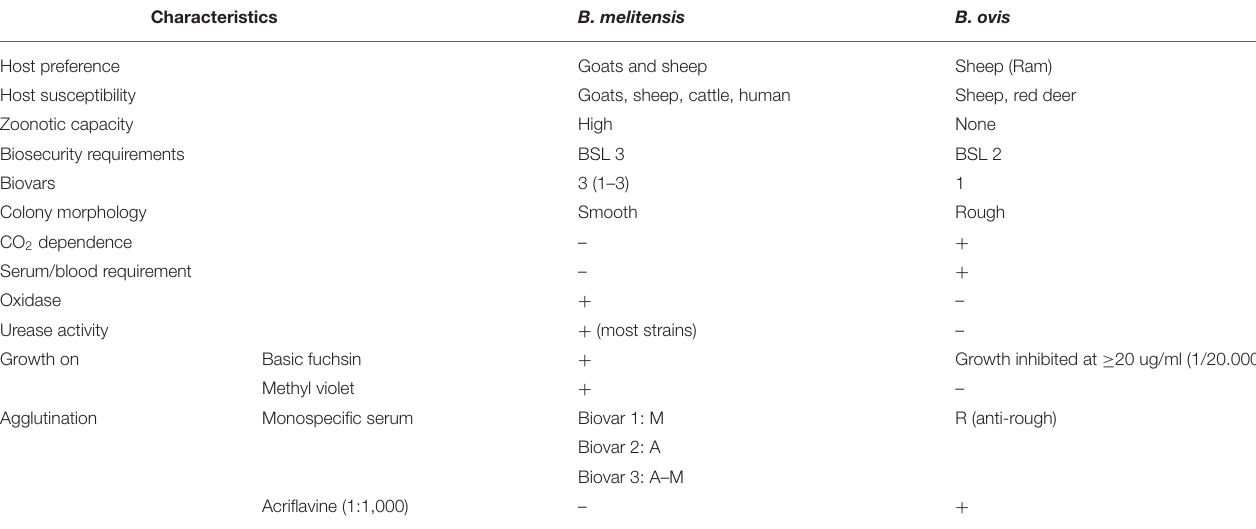
TABLE 1 | Main differences between B. melitensis and B. ovis .